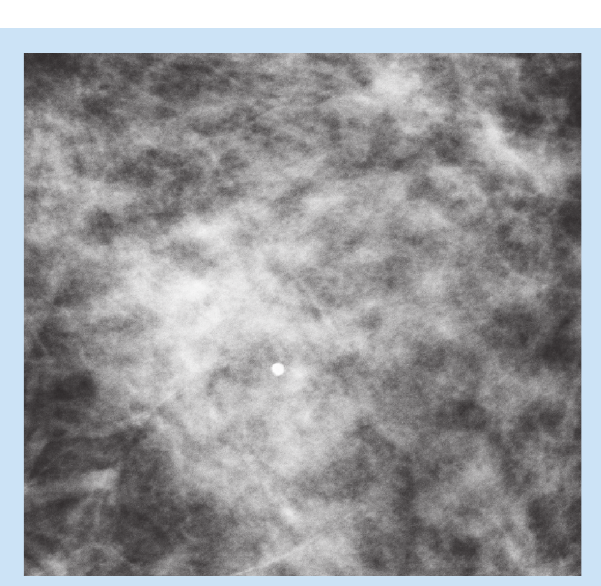
Fig. 5. Patient 5 – single round calcification (with mass); calcification pattern is